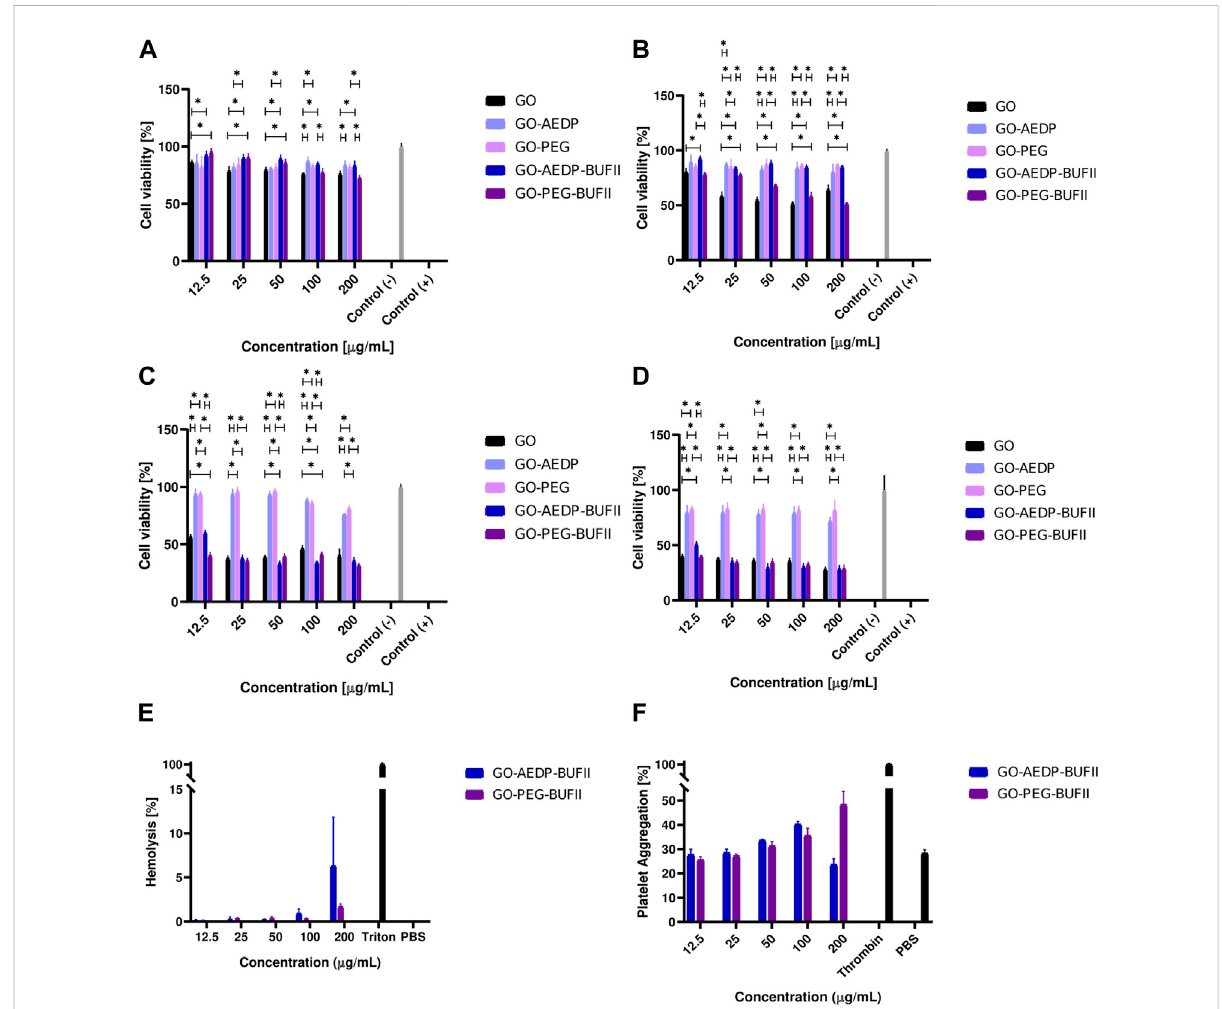
FIGURE 4 Biocompatibility tendencies of the developed nanobioconjugates. Cytotoxicity tendencies were evaluated in: Vero cells after incubation with treatments for (A) 24 h, (B) 48 h; and THP-1 cells after incubation with treatments for (C) 24 h, (D) 48 h. Results marked with (*) indicate signi fi cant differences between them ( p -value < 0.05). Hemocompatibility assays were conducted to determine: (E) Hemolytic effect and (F) Platelet aggregation